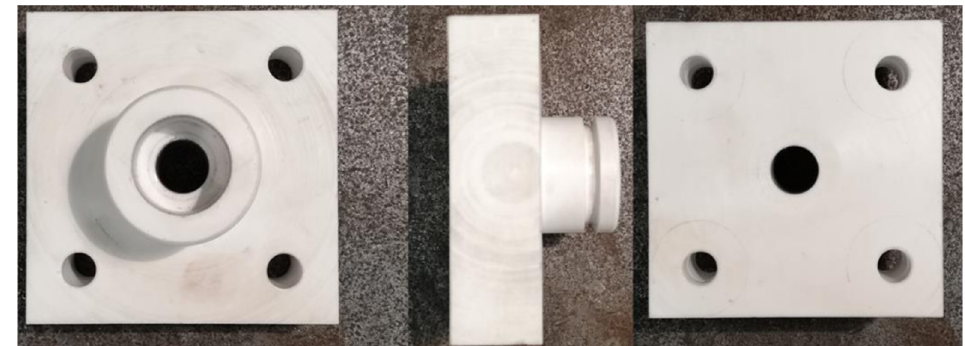
Figure 9. End cap made of PET plastic tested by Lubecki et al. in [47].